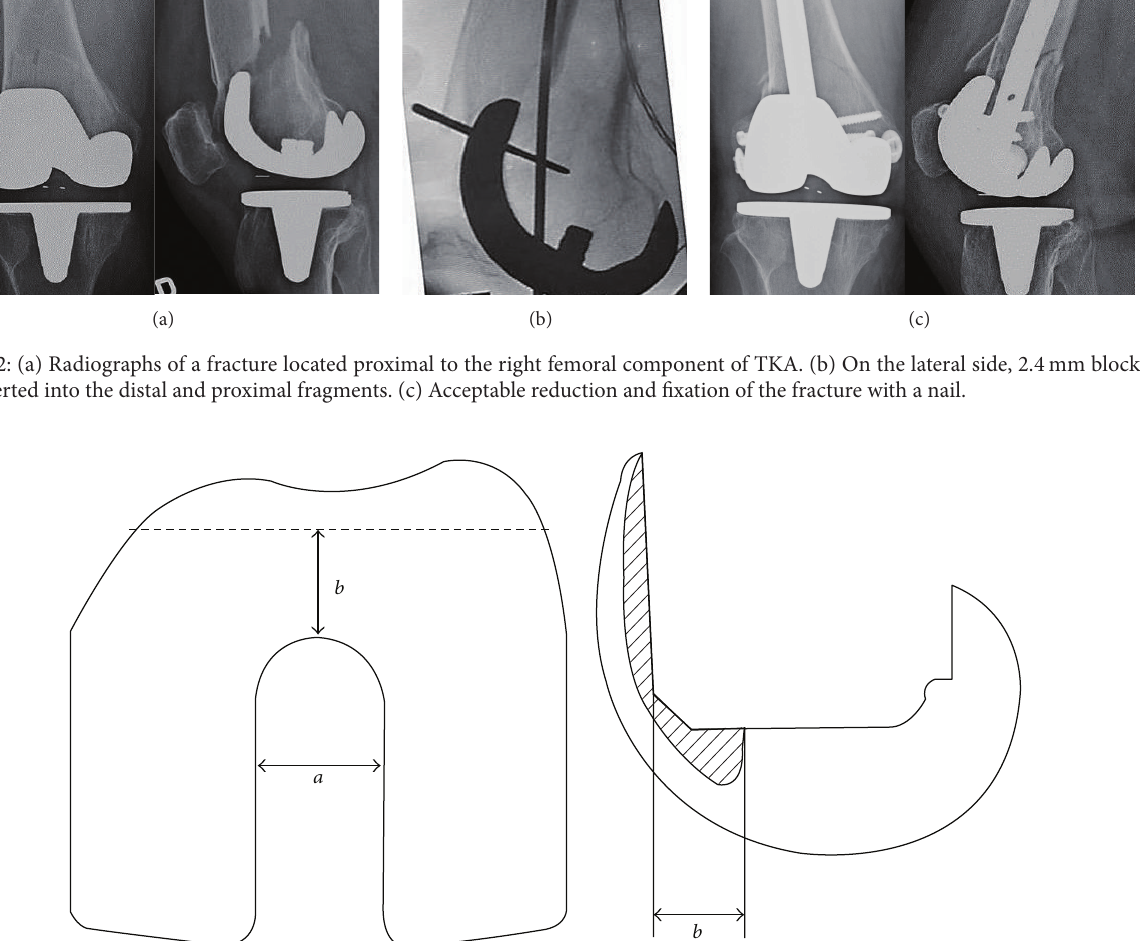
Figure 3: Intercondylar width of the femoral component (a) and distance from the anterior femoral osteotomy phase to the anterior edge of the open box component